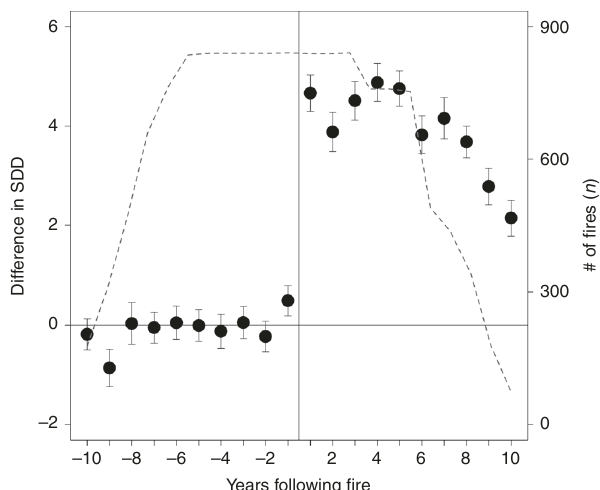
Fig. 2 Change in mean snow disappearance date (SDD) before and after fi re. SDD was evaluated for all burned forests ( n = 841; dashed line) located in the western U.S. seasonal snow zone using 2000 – 2016 MODIS satellite measurements. Forest fi re resulted in a clear and immediate shift in SSD, with impacts of fi re starting to decline after ~8 years but persisting for >10 years. Error bars indicate the standard error of the